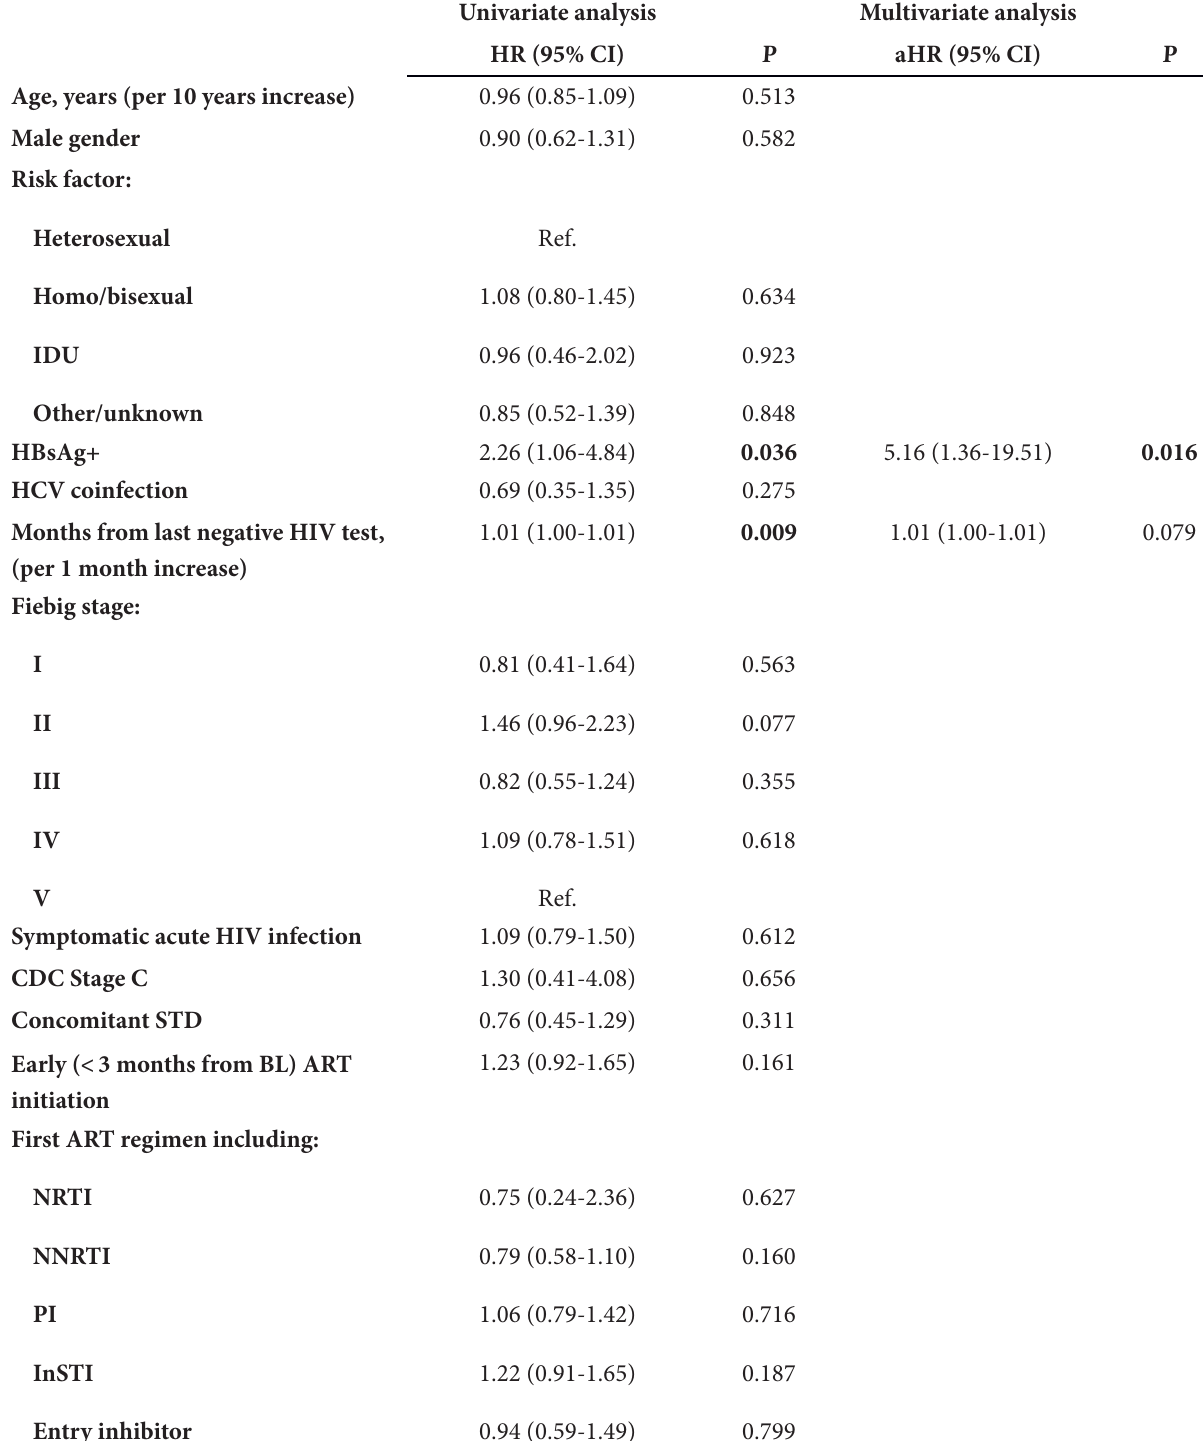
Table 4. Predictors of time to virological suppression – Cox regression analysis Univariate analysis Multivariate